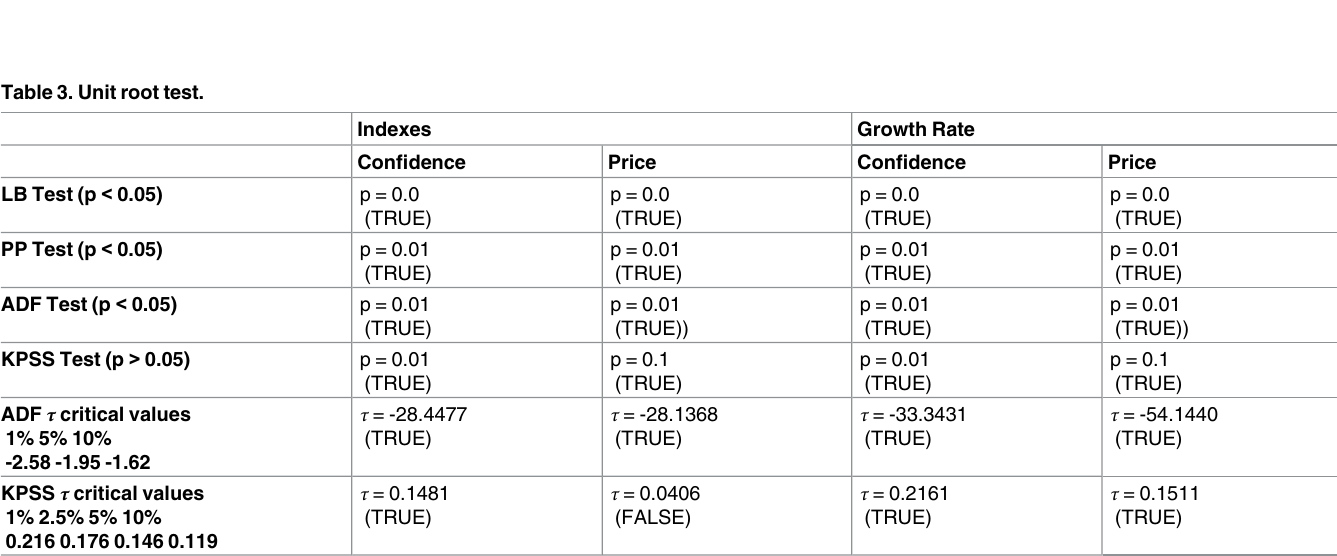
Table 3. Unit root test.